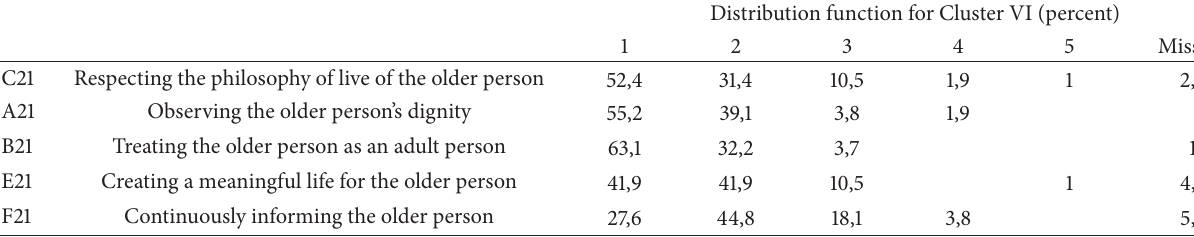
Table 8: Cluster VI: Possibilities for dignified